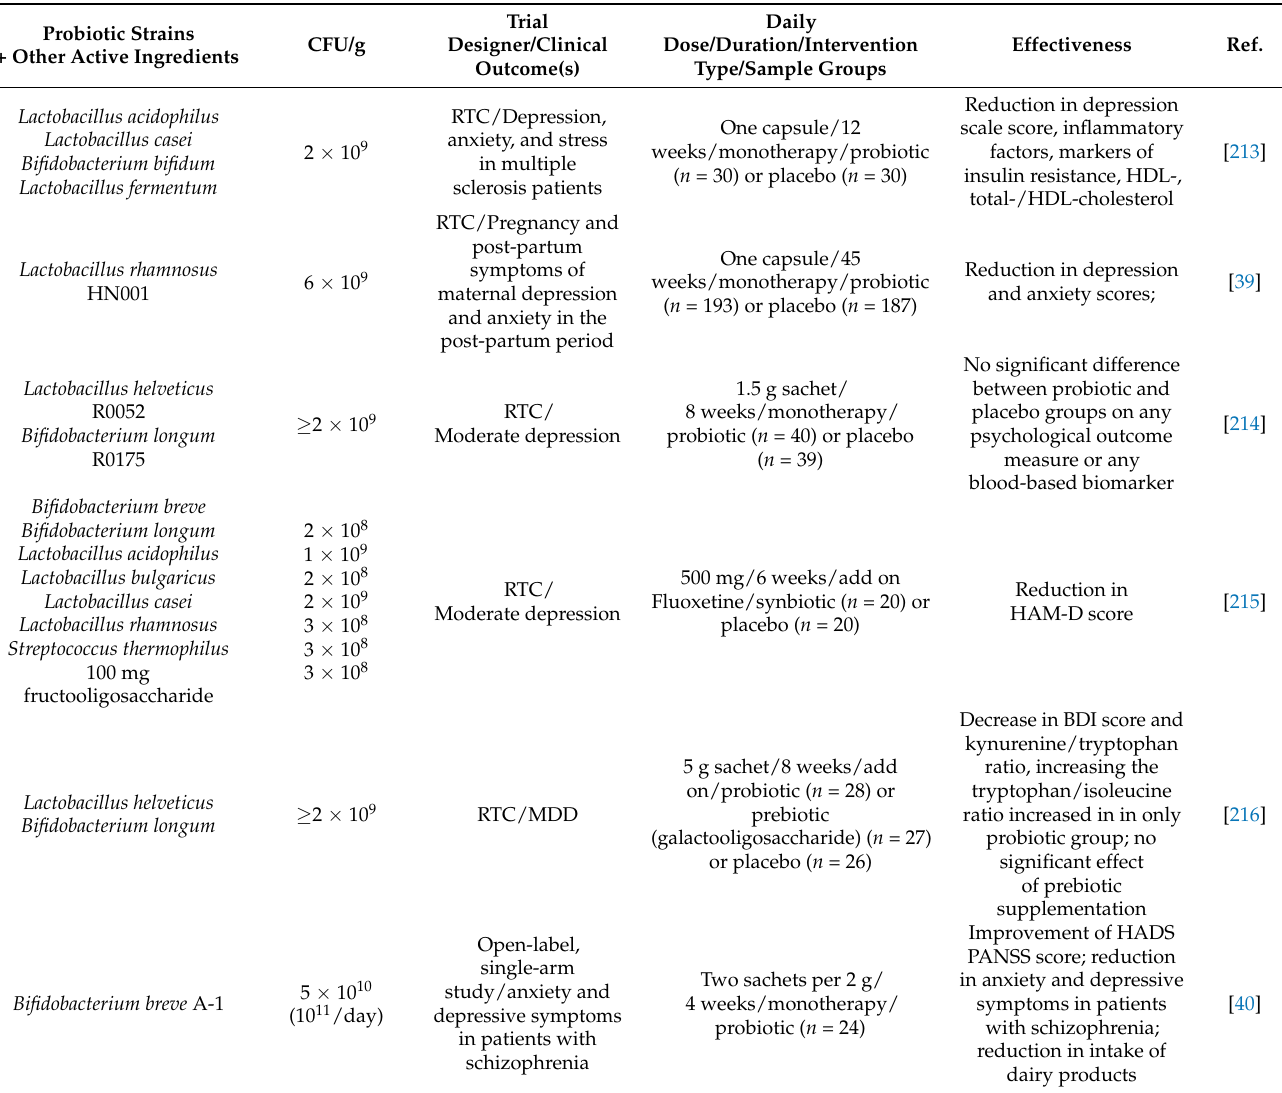
Table 3. Summary of probiotic strains used as psychobiotics in clinical trials on depression (last five